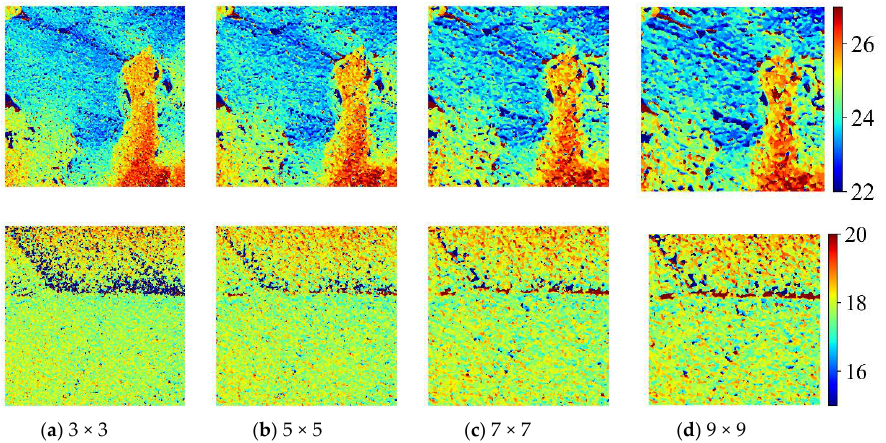
Figure 10. Real objects for qualitative tests. ( a ) A broken cork, ( b ) a leaf.